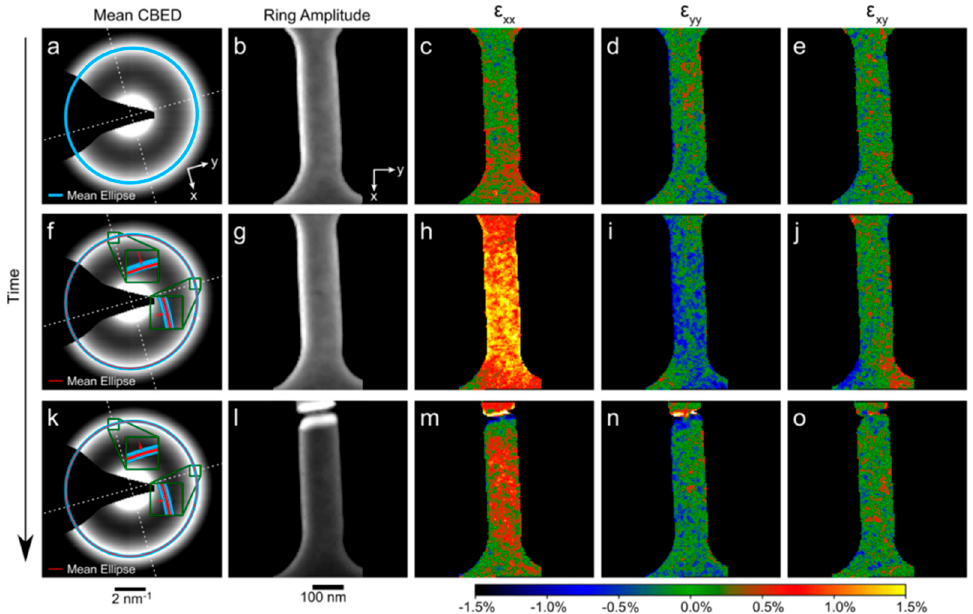
Figure 3. Results from the nanodiffraction experiments during in situ deformation. The average diffraction patterns and a virtual dark-field images are shown along with the color-coded strain maps. Three different times are shown. The sample is deformed under continuous loading ( a – e ) and ( f – j ) before catastrophically fracturing. Evolution of local strain continues even after the sample fractures ( k – o ). Reproduced from [80], with permission of Applied Physics Letters, 2018.